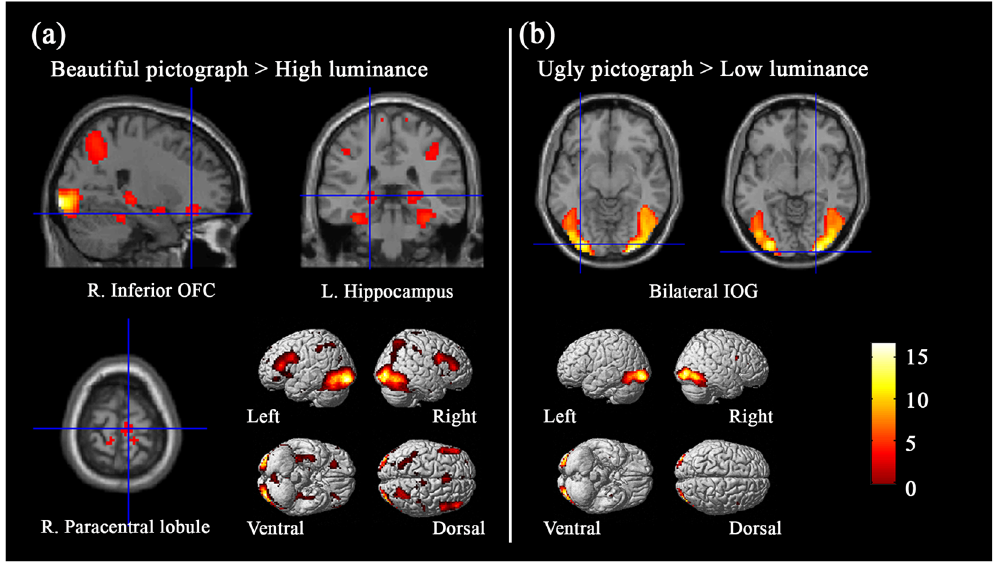
Figure 1. The main cerebral areas for aesthetic judgments of